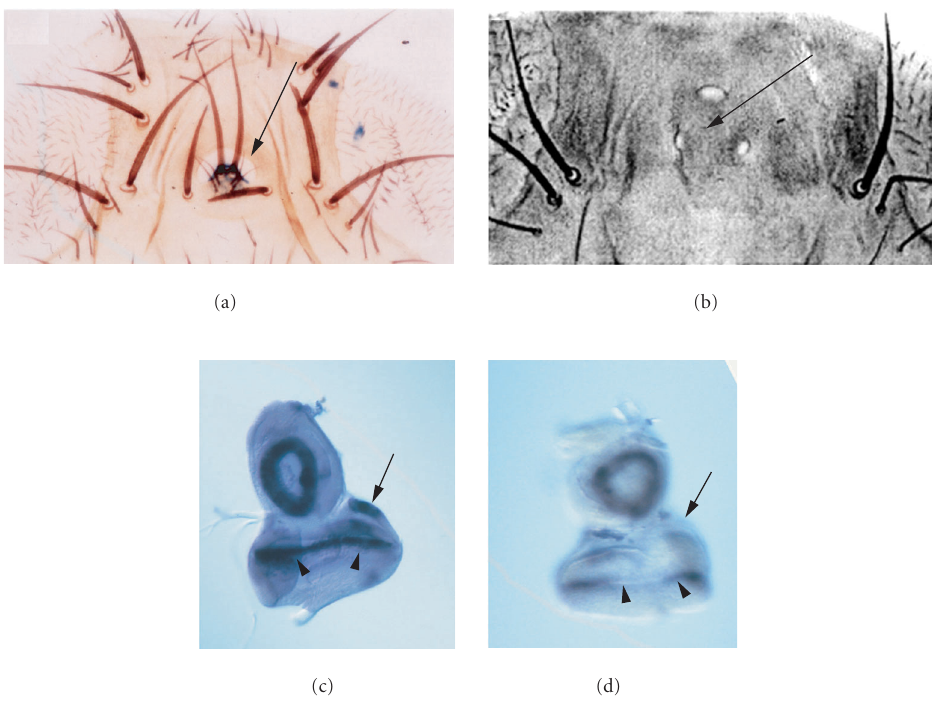
Figure 5. Regulation of E(spl) expression by hh. (a) and (b) Dorsal views of the head capsules of flies of the indicated genotypes. (c) and (d) Eye-antennal discs hybridized with a digoxigenin-labeled E(spl) probe. (a) N ts 1 /Y fly head. The ocelli are fused (arrow) and the intraocellar cuticle is lost. (b) A complete loss of bristles (arrow) was obtained in Gal4 C 591 /+ and UAS - m 7/+ flies. (c) In situ hybridization screening using m 7 cDNA demonstrates the presence of m 7 mRNA in ocellar primordium (arrow), morphogenetic furrow (arrowheads), and antennal disc. (d) Elimination of hh in hh ts 1 / hh ts 1 eye imaginal discs abolishes E(spl) expression in the ocellar primordium (arrow) and significantly disrupts its expression in the morphogenetic furrow